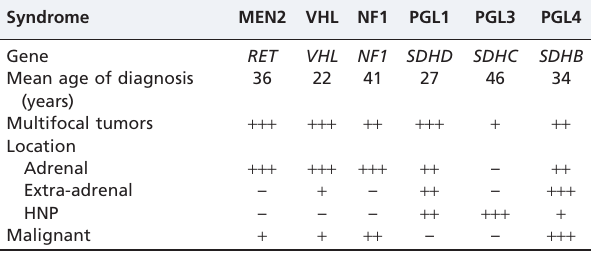
Table 3 - Comparison of pheochromocytoma-associated and paraganglioma-associated